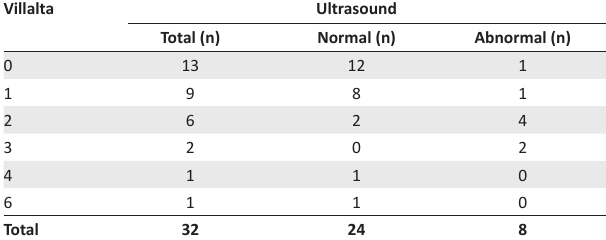
TABLE 5: Villalta compared with ultrasound.